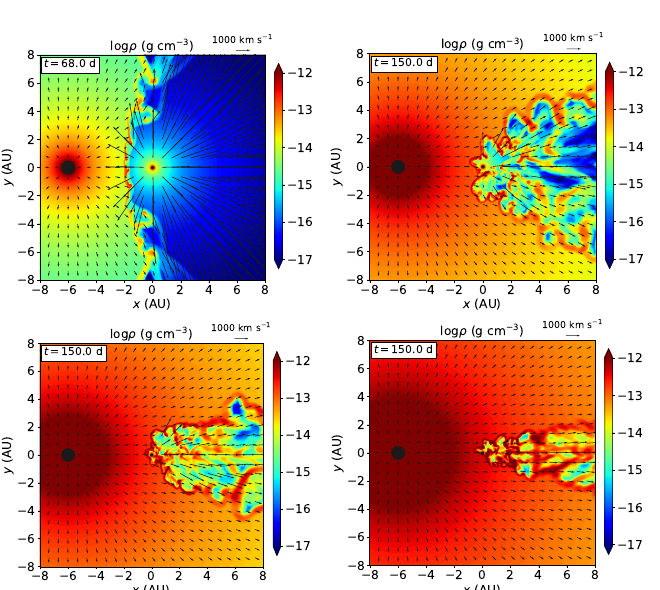
Figure 2. The density of the wind for some of the simulations we run on a slice in the orbital plane. The primary is on the left side and the secondary is in the centre. Upper left: Run 1 ( η = 0.2). Upper right: Run 2 ( η = 0.01). Lower left: Run 3 ( η = 0.005). Lower right: Run 5 ( η =